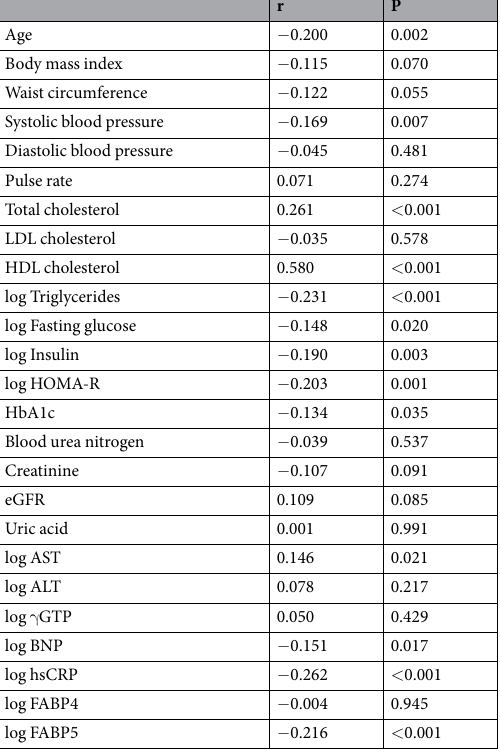
Table 2. Correlation analysis for cholesterol efflux capacity (n = 250). AST, Aspartate transaminase; ALT, Alanine transaminase. BNP, brain natriuretic peptide; eGFR, estimated glomerular filtration rate. FABP4, fatty acid-binding protein 4; FABP5, fatty acid-binding protein 5. γ GTP, γ -glutamyl transpeptidase; hsCRP, high- sensitivity C-reactive